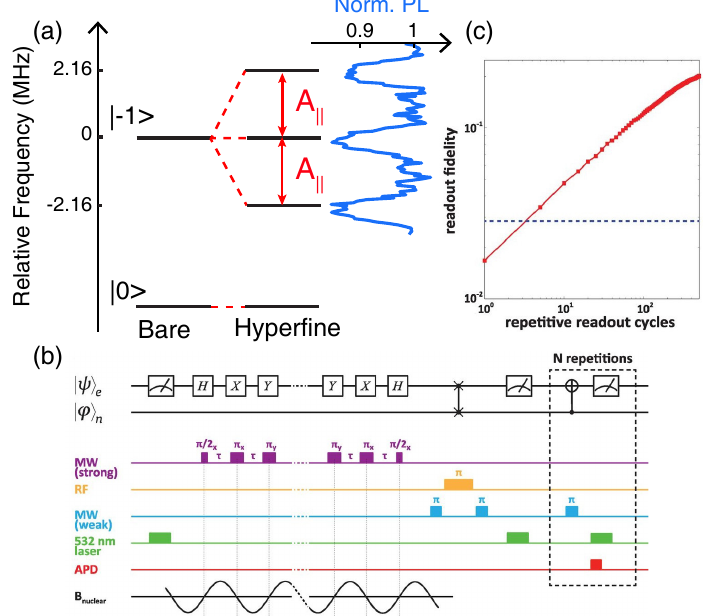
Figure 4. Nuclear-assisted readout. ( a ) Energy-level diagram showing the splitting of the m s = − 1 spin state into a triplet through hyperfine coupling with 14 N ( A || = 2.16MHz). The data at the right show the normalized PL response to a pulsed electron-spin resonance measurement. ( b ) Quantum circuit and measurement timing diagram used to detect proteins on the diamond surface using a nitrogen nuclear spin as a memory for storage. ( c ) The readout fidelity, the inverse of spin readout noise (Equation (24)), as a function of repetitive readout cycles. Panels (b,c) are from [17]. Reprinted with permission from